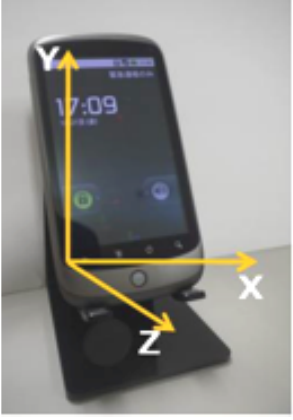
Figure 3. The definition of the axes of an accelerometer in an Android